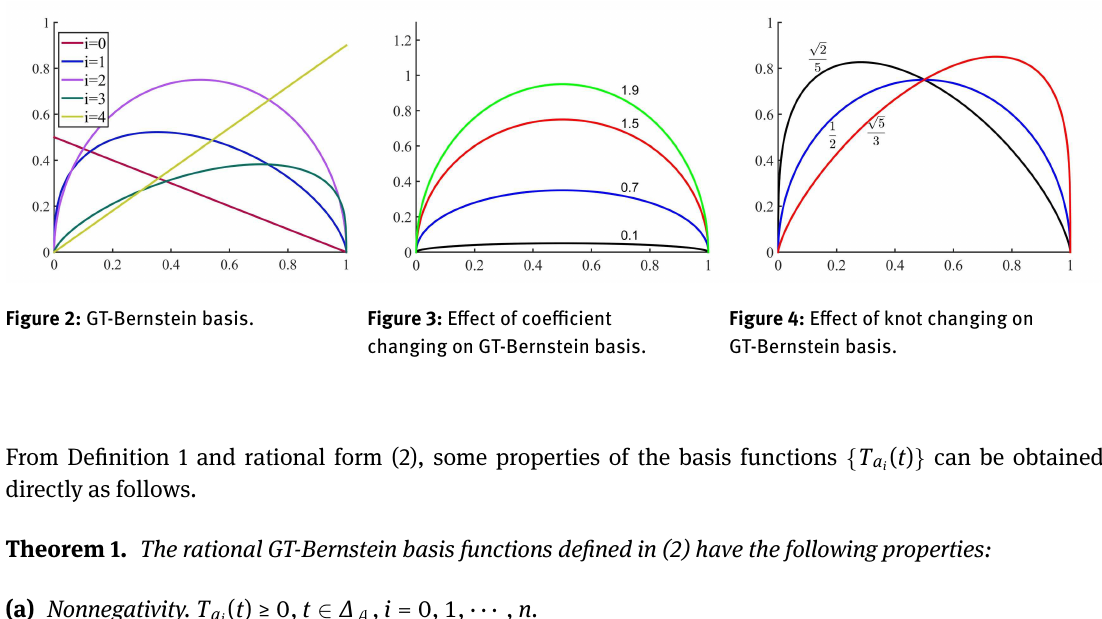
changing on GT-Bernstein basis.